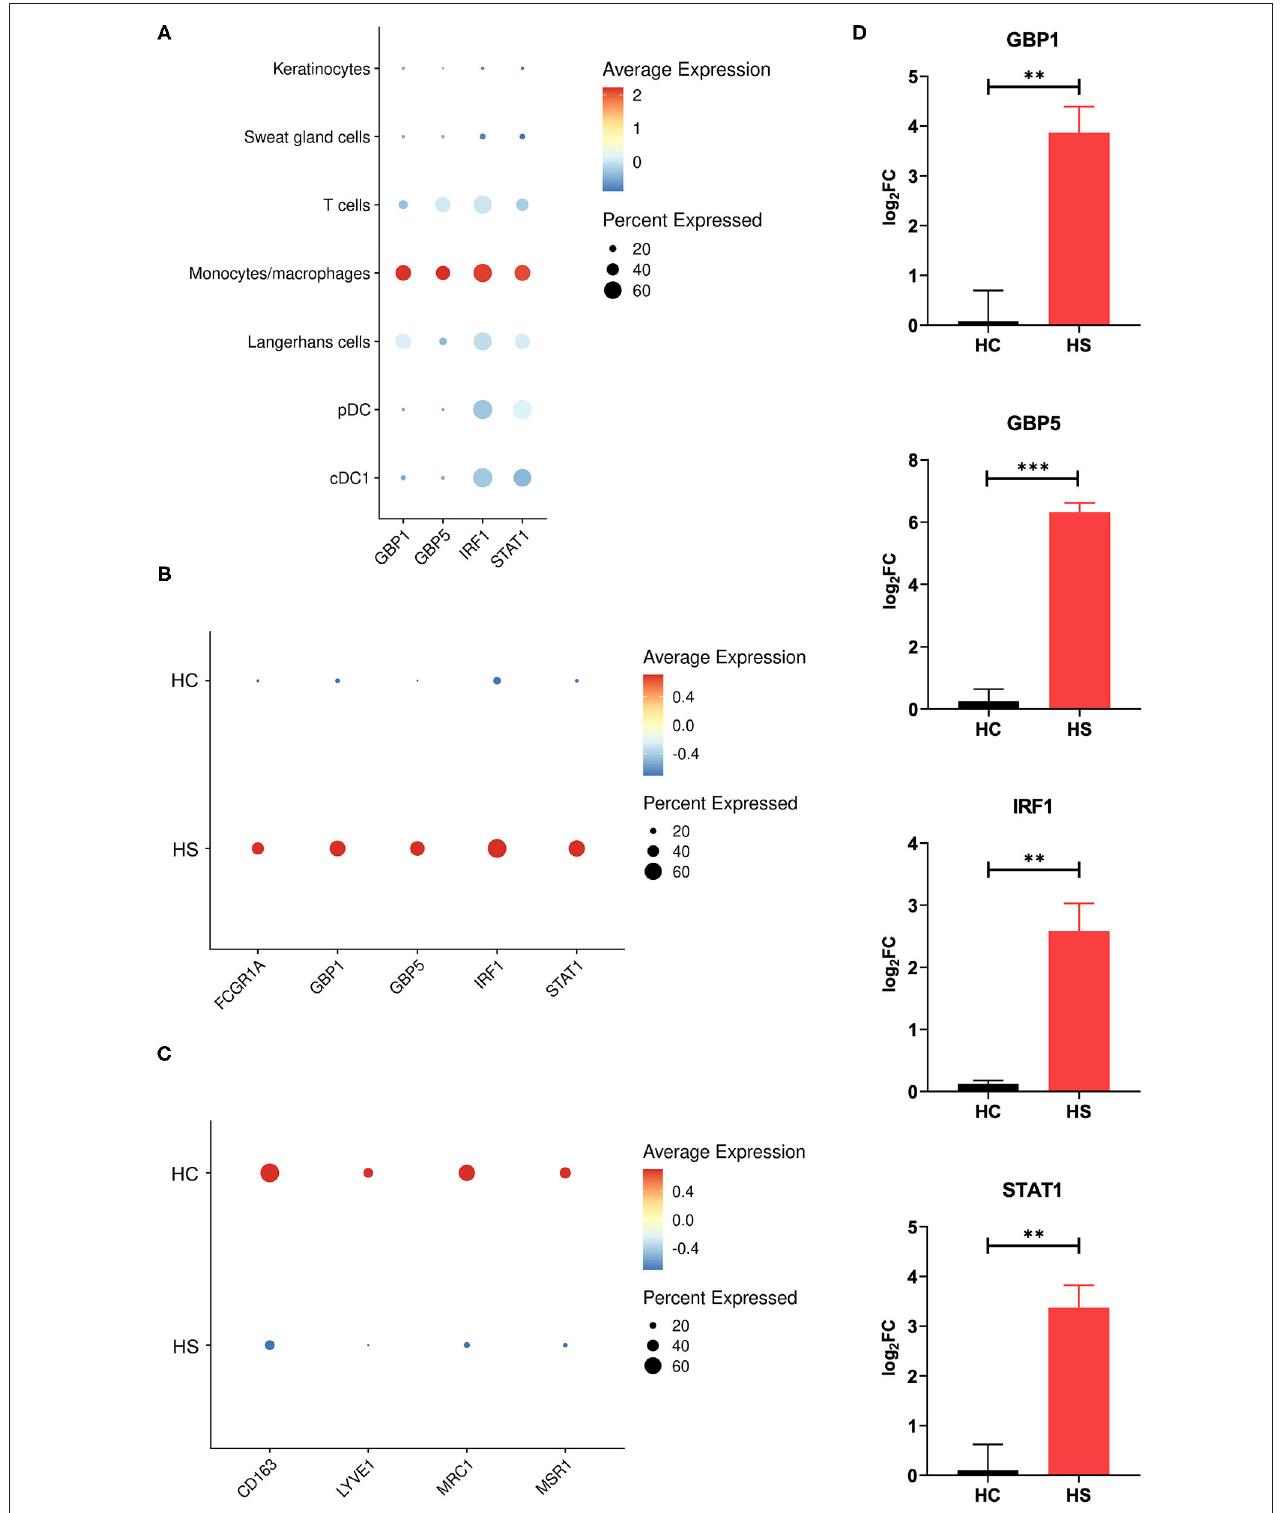
FIGURE 4 | M1 macrophage genes are more abundantly expressed in HS skin. (A) Dot plot showing the percent expressed and average expression of select M1 macrophage genes between key cellular populations in HS skin. (B) Dot plot showing the percent expressed and average expression of select M1 macrophage